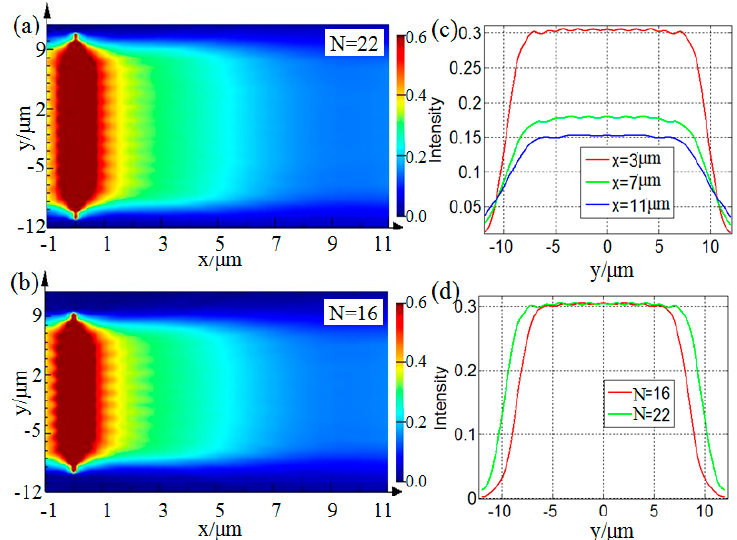
Figure 2. The simulated intensity of the flat top SPP beams with w o = 1.22 λ spp , ( a ) N = 22, ( b ) N = 16. ( c ) The transverse profile intensities extracted from ( a ) at x = 3, 7, 11 μ m. ( d ) The transverse profile intensity distributions at x = 3 μ m extracted from ( a ) and ( b ).